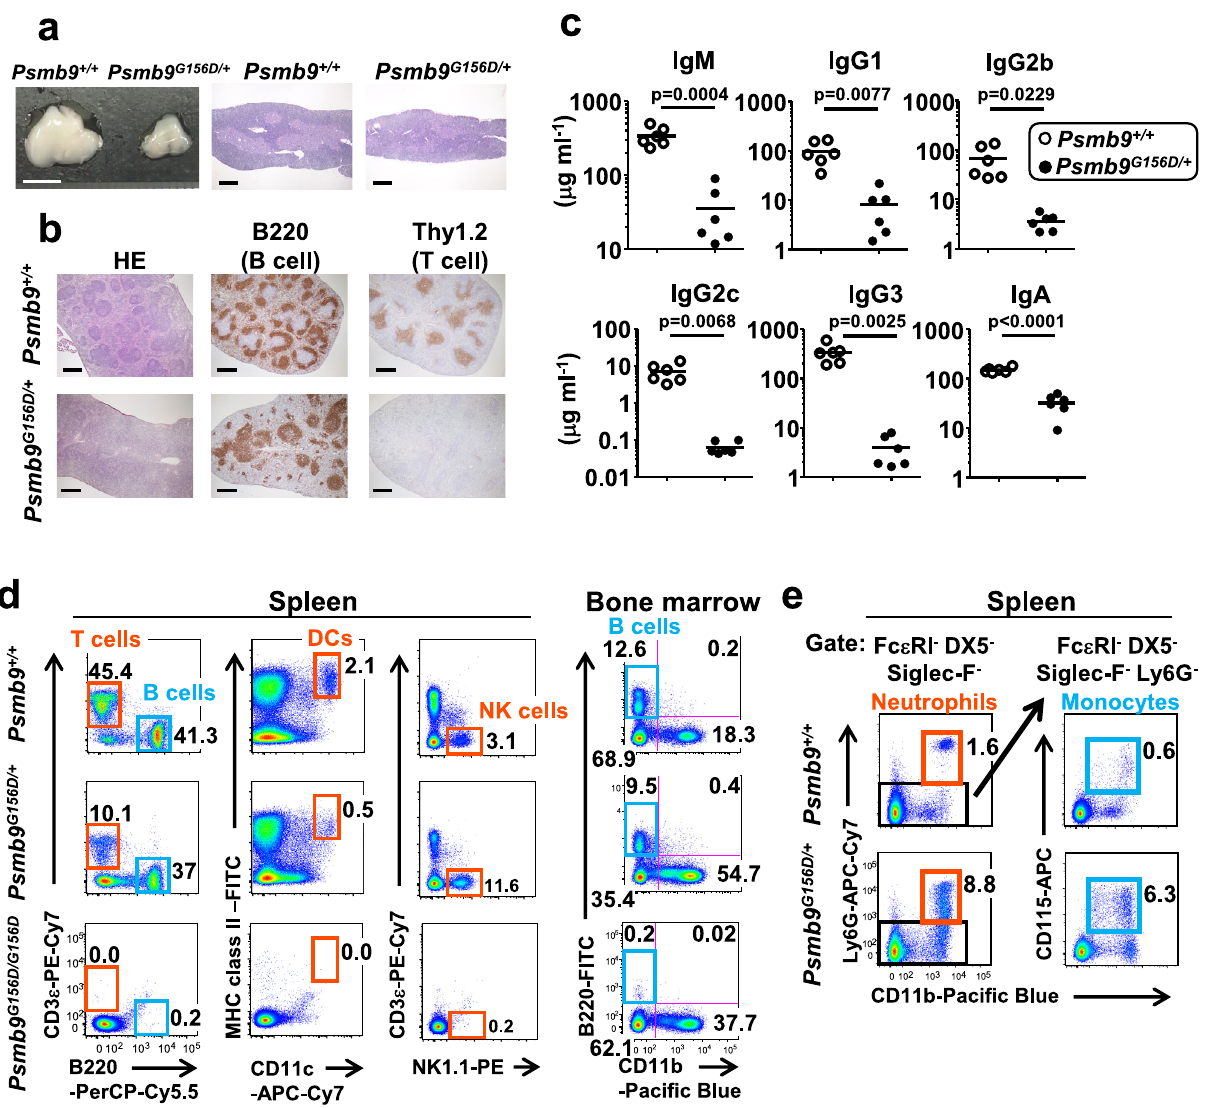
Fig. 5 Immunological phenotype of mice carrying the PSMB9 G156D mutation. a A photograph and histological images of the thymus. Scale bars in the leftmost and the other two panels represent 5 mm and 500 μ m, respectively. Representative images from three mice were shown. b Cryosections of the spleen stained with hematoxylin and eosin (HE, left panel), anti-B220 Ab (middle panel), or anti-Thy1.2 Ab (right panel). Scale bars,500 μ m. Representative images from three individual mice were shown. c Serum immunoglobulin levels. n = 6 in each group. Statistical analysis was performed with two-sided Welch ’ s t -test. d FACS analysis of B and T cells, DCs, and NK cells, in the spleen or bone marrow. The numbers represent the percentages of the cells within the indicated gates or each quadrant among splenocytes or bone marrow cells. e FACS analysis of neutrophils and monocytes in the spleen. The left and right panels show Fc ε RI − DX5 − Siglec-F − and Fc ε RI − DX5 − Siglec-F − Ly6G − cells, respectively. The numbers represent the percentages of neutrophils and monocytes among